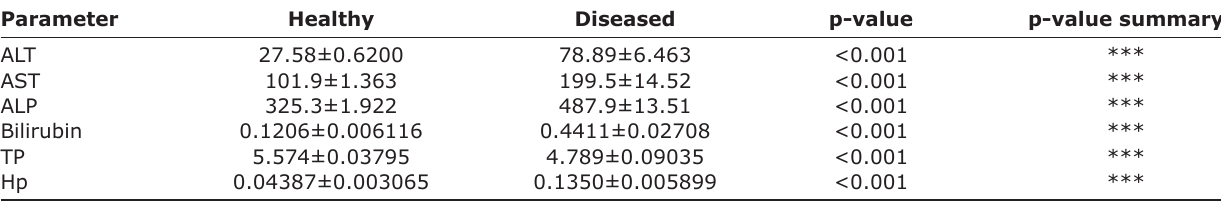
Table-2: The infection rate among healthy and diseased animals and their p-value and significance level, depending on analysis of biochemical liver markers. Parameter